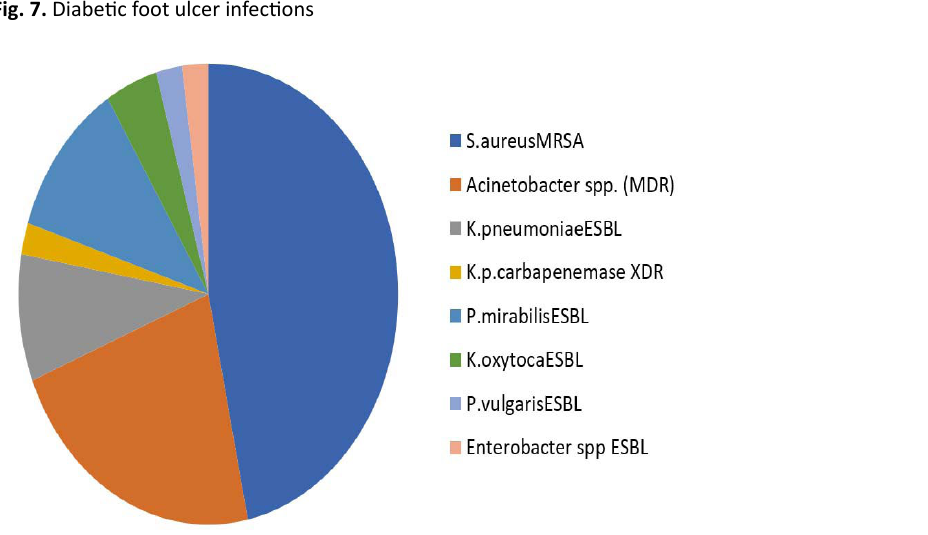
Fig. 8. High drug-resistant isolates of diabetic foot